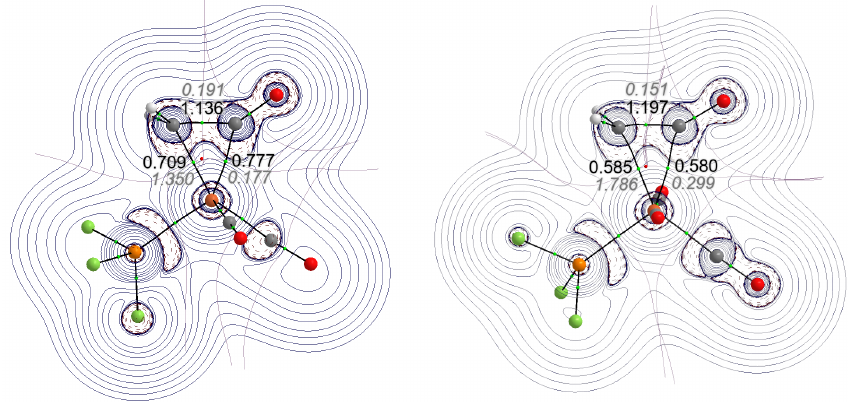
Figure 7. Contour-line diagrams of the Laplacian distribution ( ∇ 2 ρ ( r )) of the unsaturated ( 7F2 , left) and saturated ( 9F2 , right) ketene complexes with PF 3 ligand.